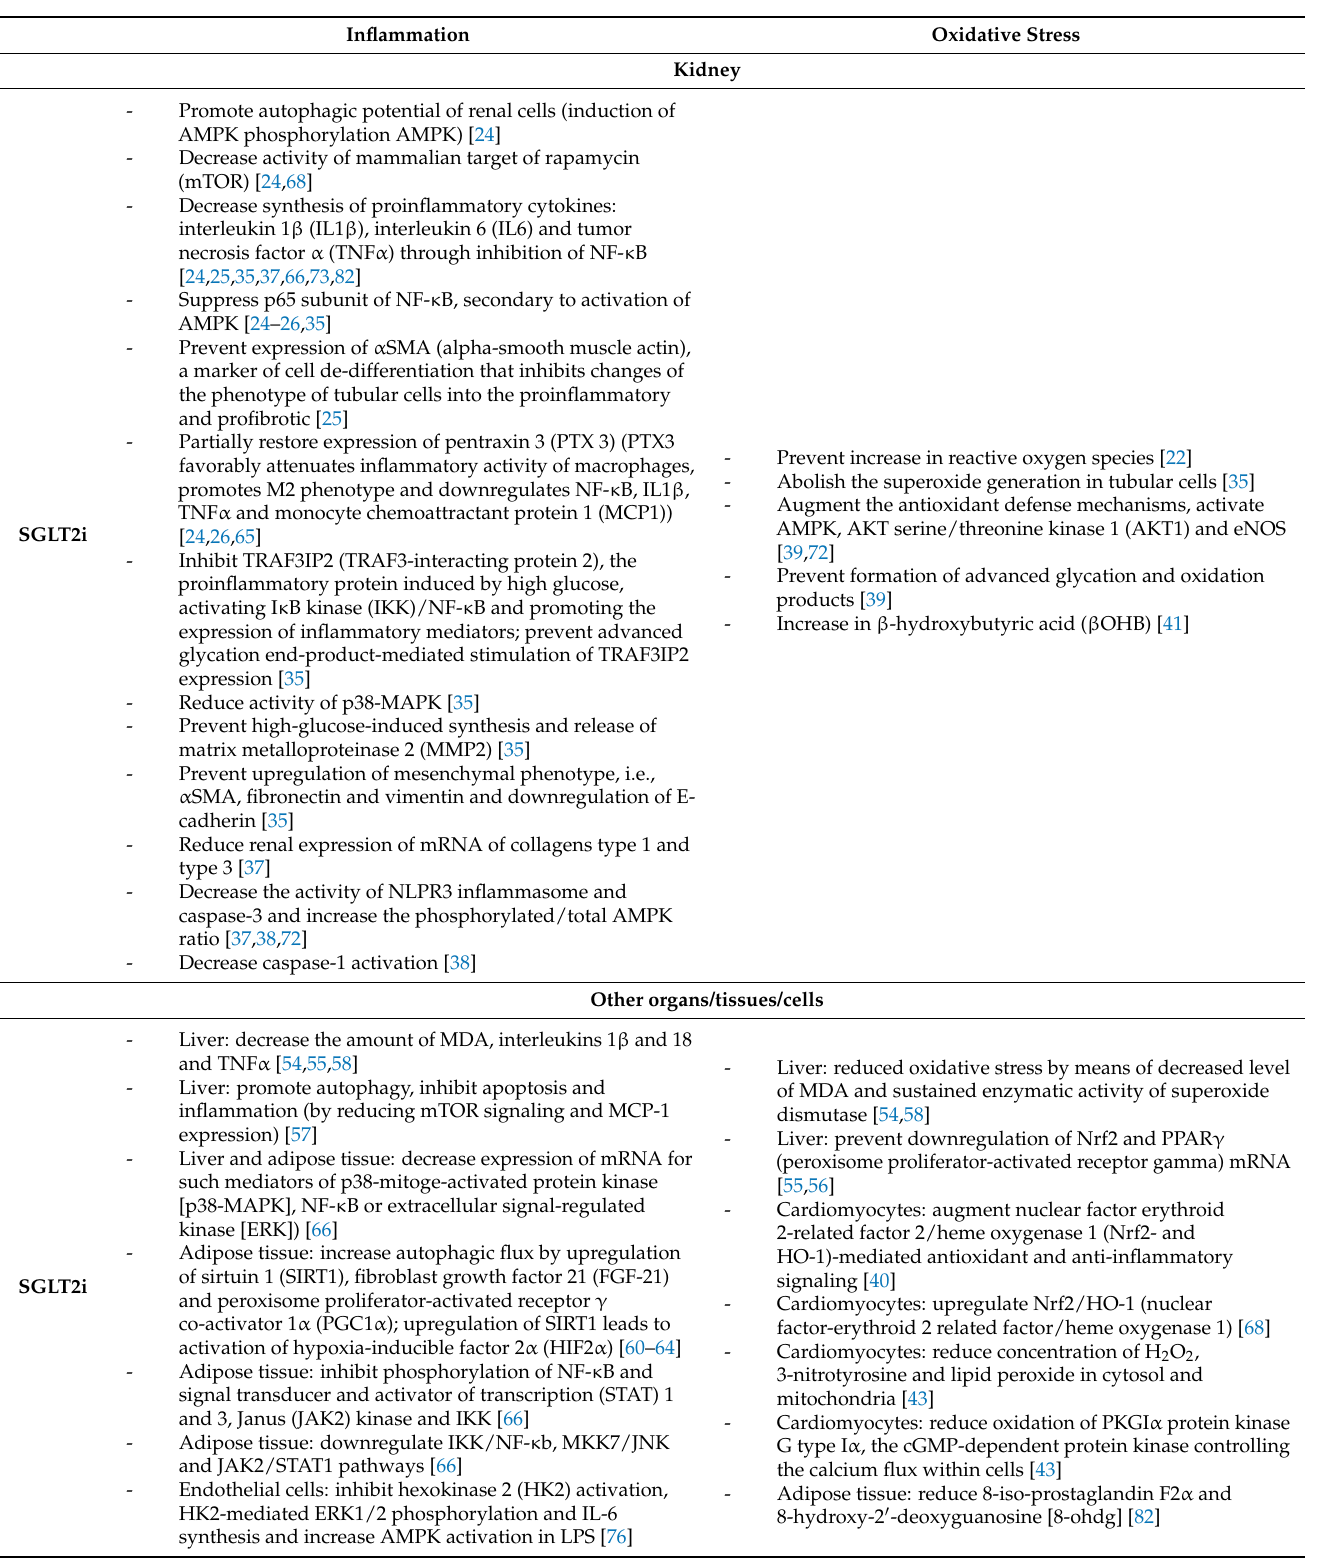
Table 1. Selected mechanisms of interactions between SGLT2 inhibitors, inflammation and oxidative stress. Inflammation Oxidative Stress